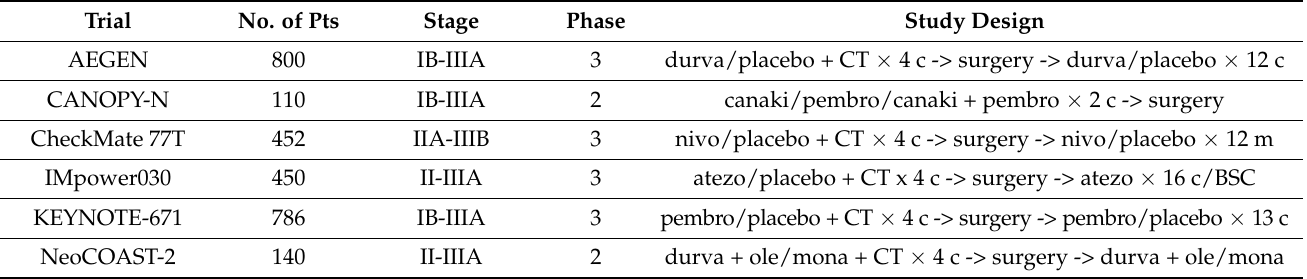
Table 2. Trials of neoadjuvant immunotherapy in resectable NSCLC (ongoing or awaiting results).